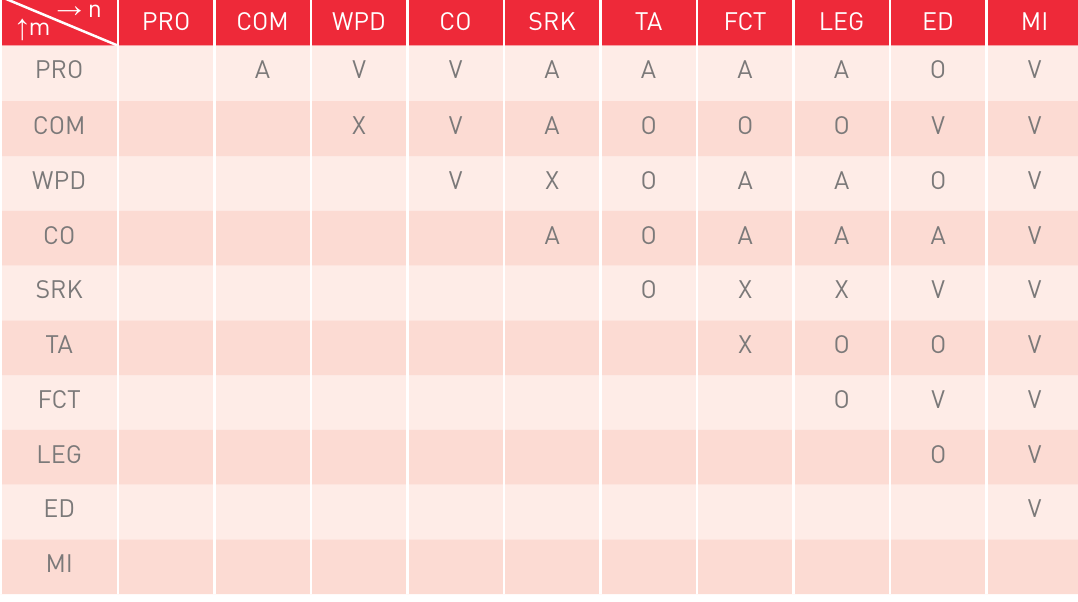
Table 5. Pairwise Relationship among barriers – SSIM (Structural Self Interaction